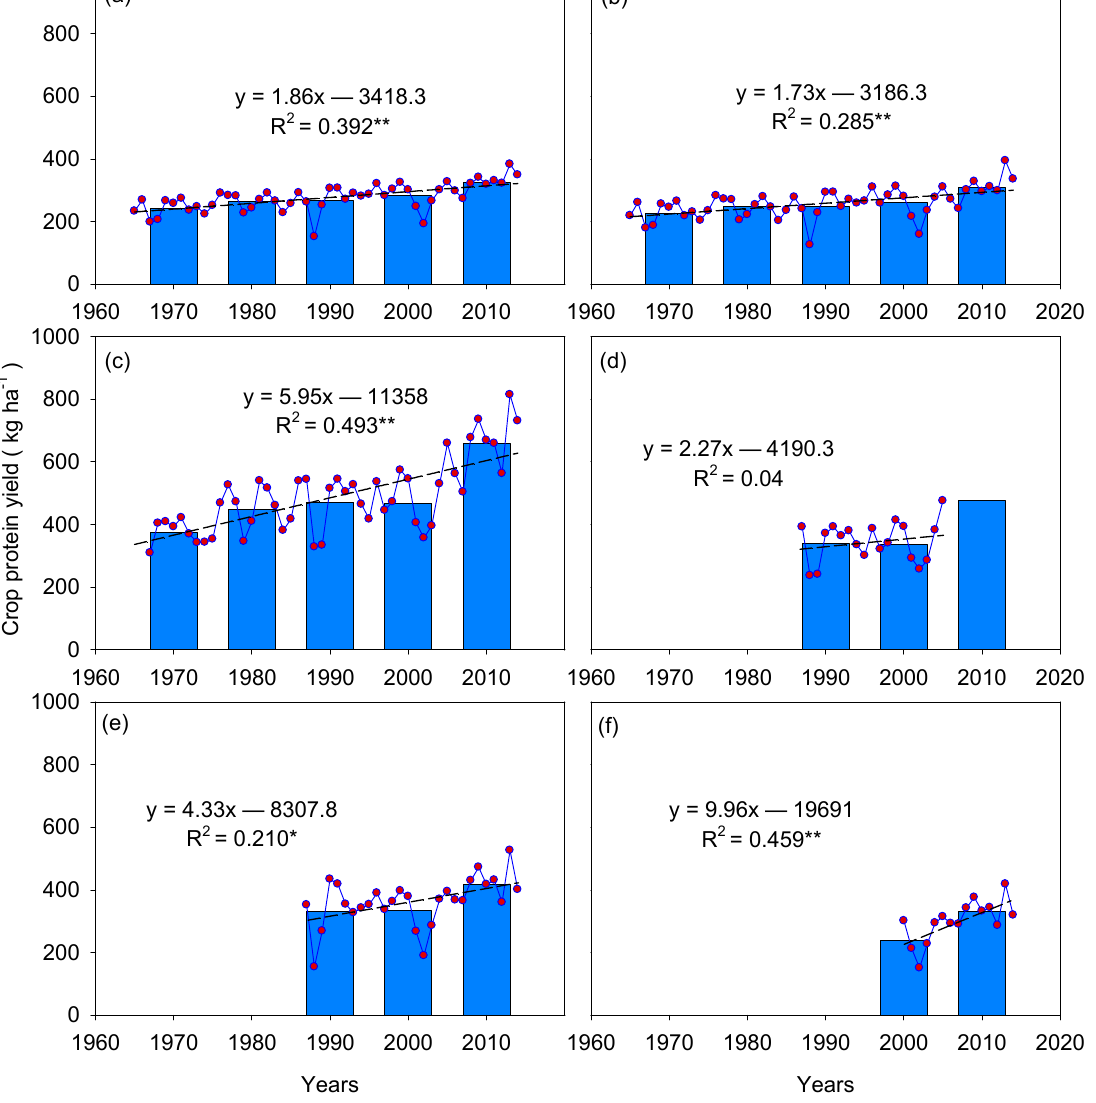
Figure 5. Variations of protein yield for six crops in Saskatchewan. The solid circles show the annual protein yields and the bars show the decadal average protein yields from 1965 to 2014. ( a ) spring wheat; ( b ) barley; ( c ) canola; ( d ) sunflower; ( e ) lentil; ( f ) chickpea. Note: * Significant difference at the 0.05 level; ** significant difference at the 0.01 level.